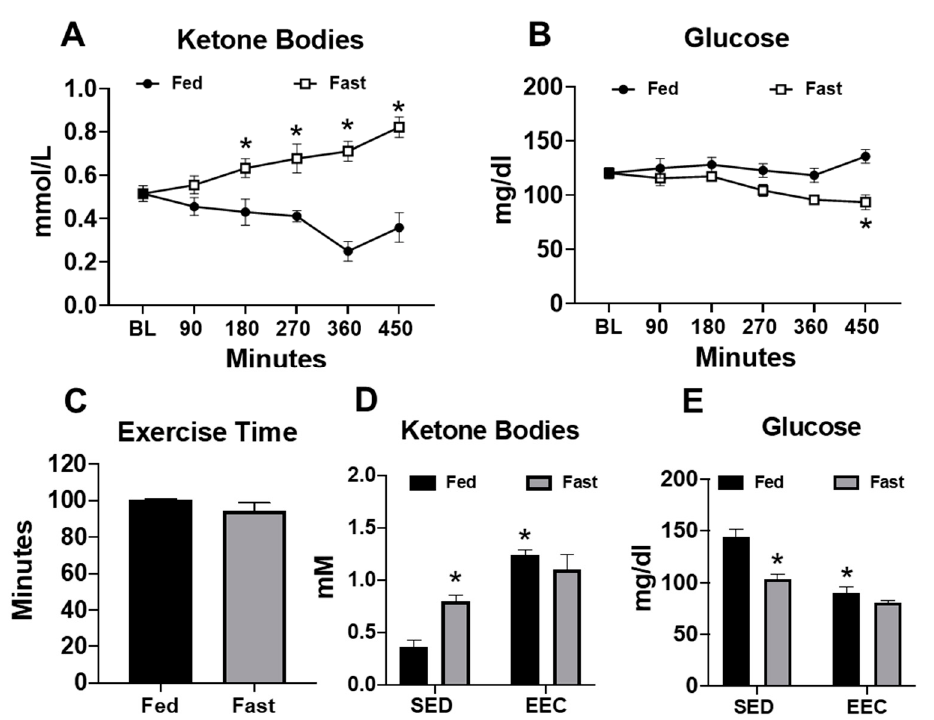
Figure 1. Serum ketone bodies increase in response to fasting and/or endurance exercise. ( A ) Serum ketone bodies and ( B ) serum glucose levels measured in fed and fasted mice ( n = 9–10 per group); ( C ) exercise time in the endurance exercise capacity (EEC) test in fed and fasted mice ( n = 5 per group); ( D ) serum ketone bodies; and ( E ) serum glucose in fed and fasted mice at the end of the exercise capacity test ( n = 5 per group). Non-exercised, sedentary (SED) fed and fasted mice used for comparison ( n = 7 per group). * p < 0.05 vs. fed or fed-SED.